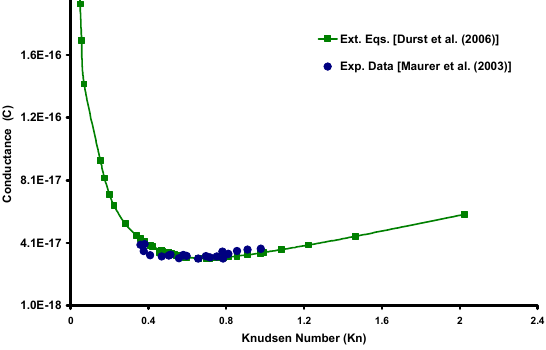
Fig. 9: Comparison of conductance versus Knudsen number with the experimental data of Maurer et al. (2003). The results show the Knudsen minima of the